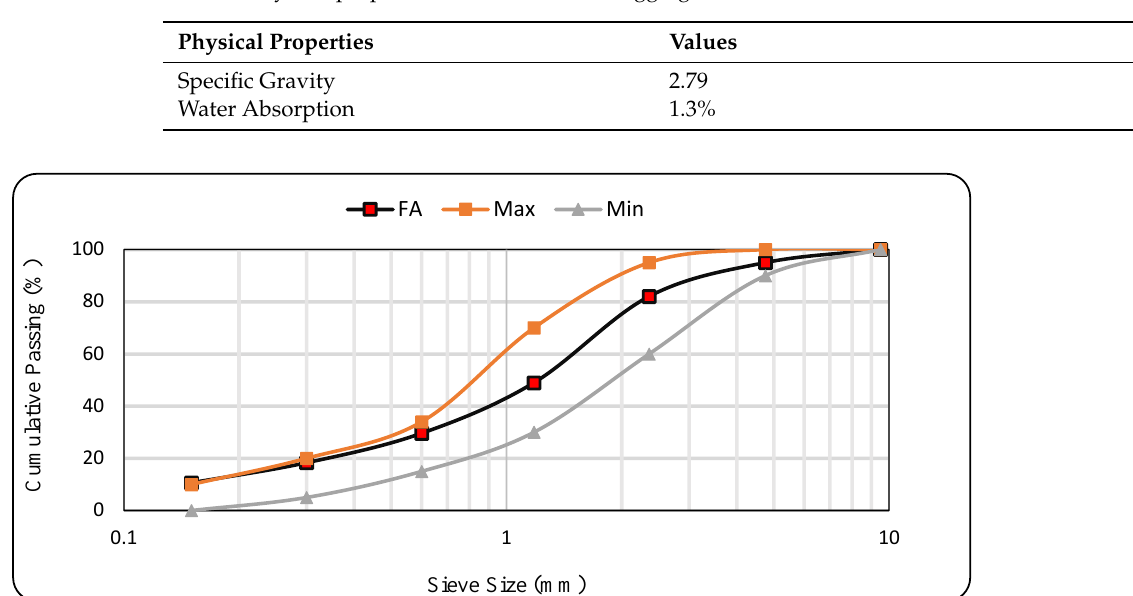
Figure 1. Particle size distribution of fine aggregate (FA) and BS EN 933-1:1997 limits.